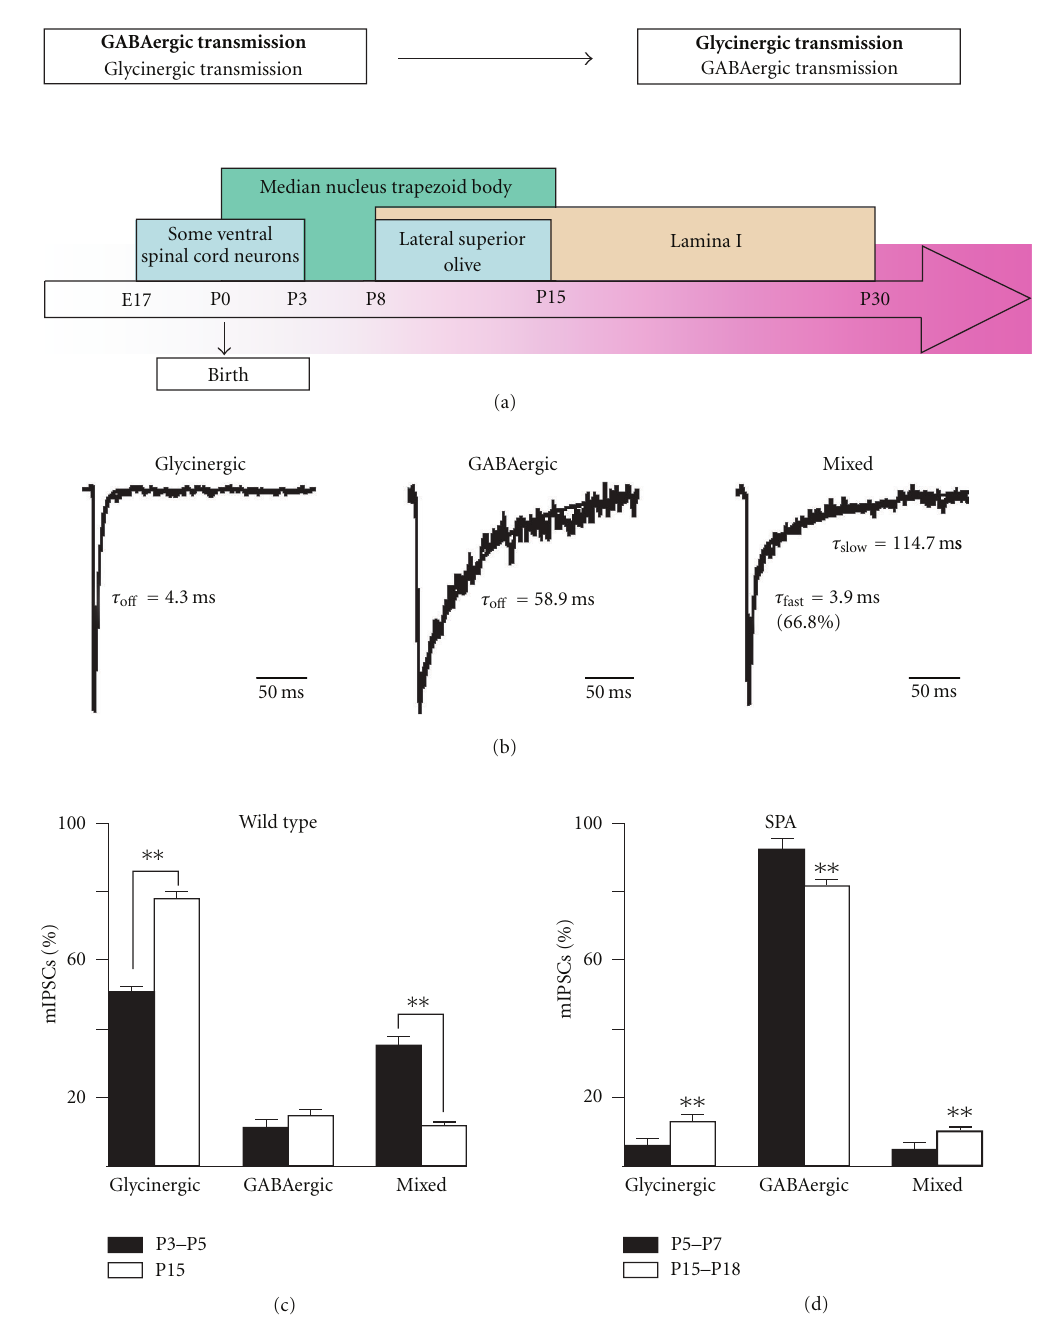
Figure 2: (a) Developmental changes in the proportions of GABAergic and glycinergic synaptic activity in various areas of the central nervous system. (b) Examples of individual glycinergic (left) GABAergic (middle) and mixed (right) miniature inhibitory postsynaptic currents (mIPSCs) recorded in a hypoglossal motoneuron at P15, in the presence of tetrodotoxin (a blocker of voltage-gated sodium channels). Note the slower decay phase of the GABAergic mIPSC compared to the glycinergic mIPSC. Decay phase of GABAergic and glycinergic events is better fitted with a single exponential function, while a double exponential function is required to fit the decay phase of mixed events. (c) Relative proportions of glycinergic, GABAergic and mixed mIPSCs at P3–P5 (black bars) and at P15 (white bars) in wild-type mice. (d) Relative proportions of glycinergic, GABAergic and mixed miniature postsynaptic events at P5–P7 (black bars) and at P15–P18 (white bars) in SPA mice. (Adapted from [118,